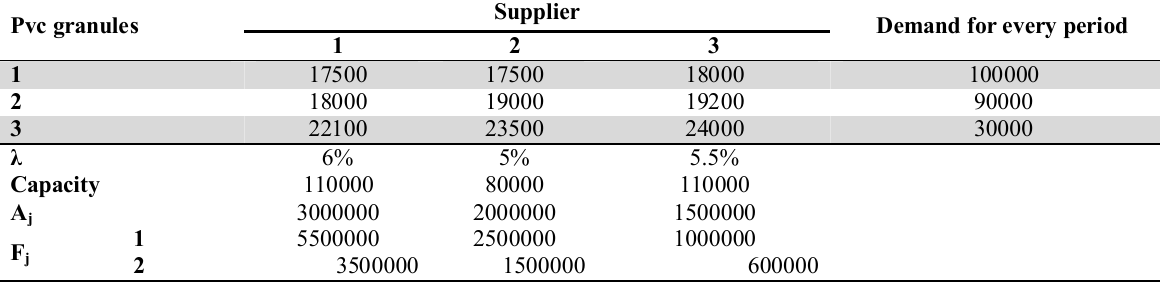
Demand, prices, capacity, ordering and transportation